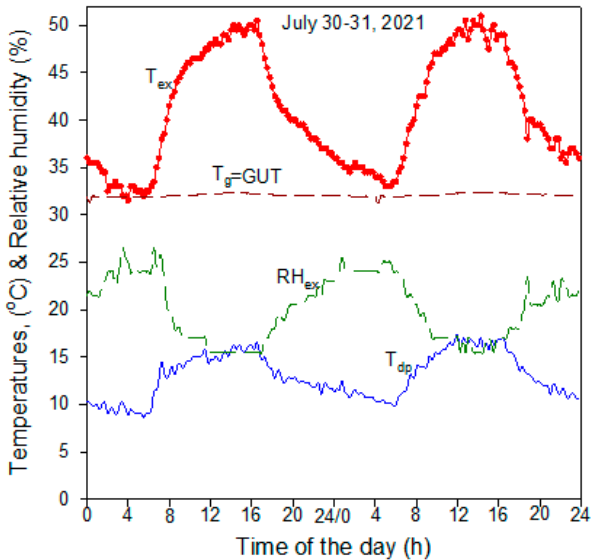
Figure 8. Diurnal variation in estimated dew-point temperature ( T dp ) of air ventilated from a greenhouse at T ex and RH ex and flowed through EAHE pipes buried at the GUT in summer season (30–31 July 2021).